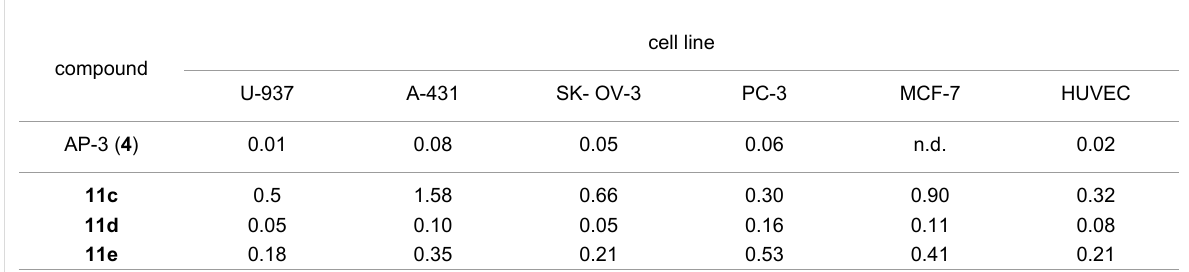
Table 1: Antiproliferative activity IC 50 [nmol/L] of 11c – e in comparison to AP-3 ( 4 ). a